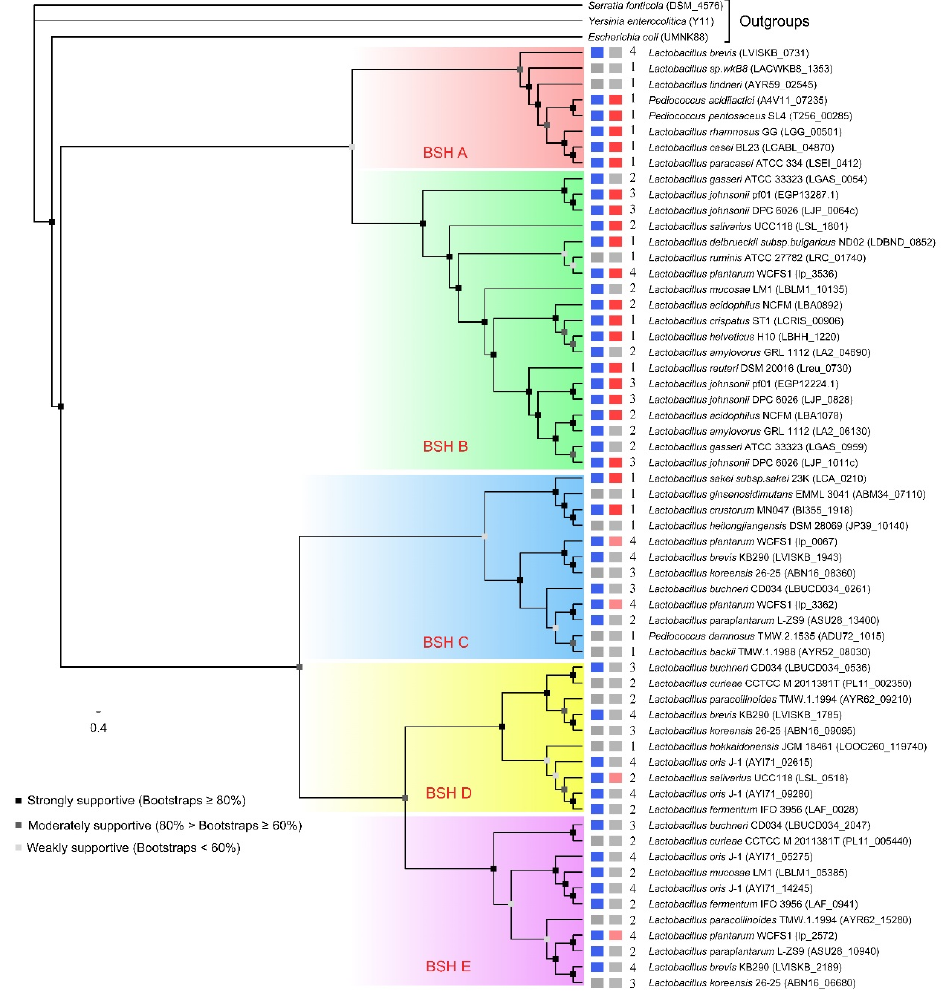
Figure 2. Phylogenetic tree of BSHs in 34 Lactobacillaceae species. The BSH subtypes are shaded by various colors. BSH A, B, C, D and E are shown in red, green, blue, yellow and purple, respectively. On the right-hand side, the rectangle of the first column denotes experimental reports of this strain or bsh genes; blue means it has been reported before and grey means it has not. The second rectangle denotes the scoring type of this BSH (see more details in Table S1), categories 2, 1 and 0 are marked with red, light red and grey, respectively. The number beside it indicates the copy number of the bsh gene in this strain.